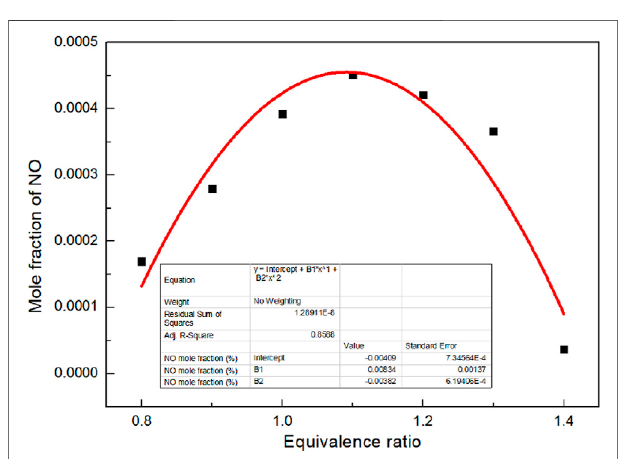
FIGURE 9 | Curve of NO mole fraction with Φ .